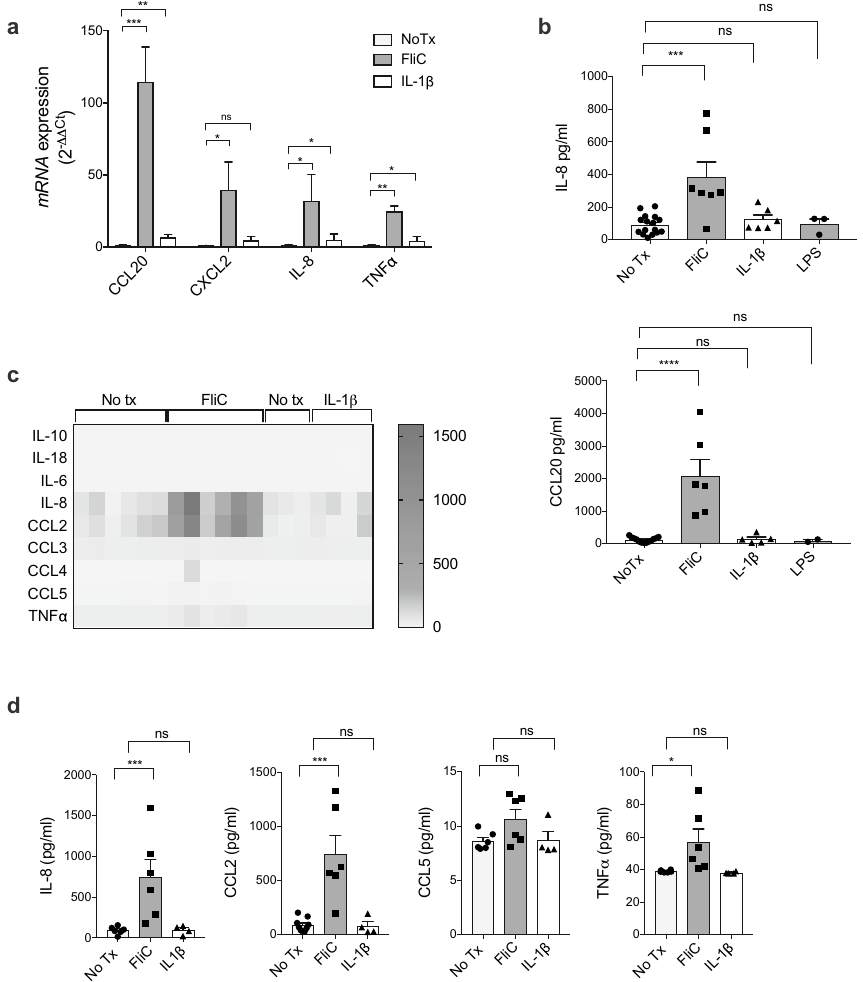
Figure 1. Human IEC responses to host (IL-1β) and bacterial stimuli (FliC, LPS). ( a ) qPCR analysis of inflammatory gene transcription after FliC or IL-1β stimulation for 4 h, expressed as fold change over untreated colonoids. ( b ) IL-8 (top) and CCL20 (bottom) protein levels secreted basolaterally by human colonoids after 4 h of stimulation with FliC or IL-1β. ( c ) Heat map representation of chemokine concentrations in the supernantants of colonoids after 4 h of stimulation with FliC or IL-1β. ( d ) Concentration of chemokines detected by Multiplex Luminex Assay in the supernatants of colonoids after 4 h of stimulation with FliC or IL-1β. Mean and SEM are indicated from n = 6–8 donors (4 adult and 2–4 pediatric). All data shown are representative of at least 2–3 independent experiments. Statistical significance calculated using unpaired Student’s t -test *, P = 0.01 to 0.05; **, P = 0.001 to 0.01; ***, P = 0.0001 to 0.001. ns = not